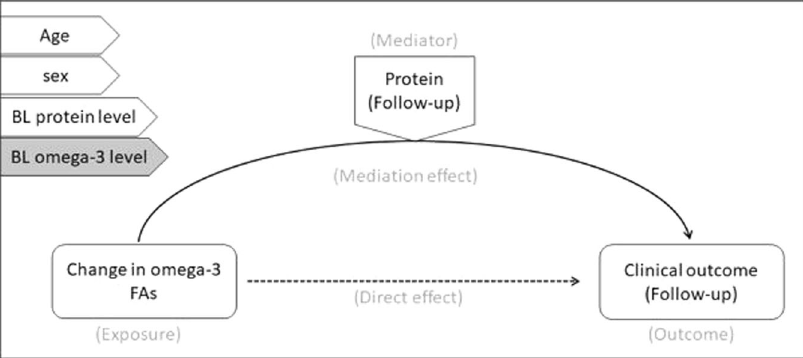
Fig. 1 Mediation model. The general structure of the mediation model mentioning the exposure (change in omega-3 levels), mediator (protein levels) and outcome variables (clinical outcome). The model was adjusted for the covariates (age, sex, baseline protein and omega-3 levels) mentioned on the left side of the picture. system and sub-pathways were the top pathways denoted by the Table 1. Participants ’ demographic, anthropometric, PUFA, and change in total omega-3 PUFA associated proteins (Table 2 and clinical characteristics at baseline and